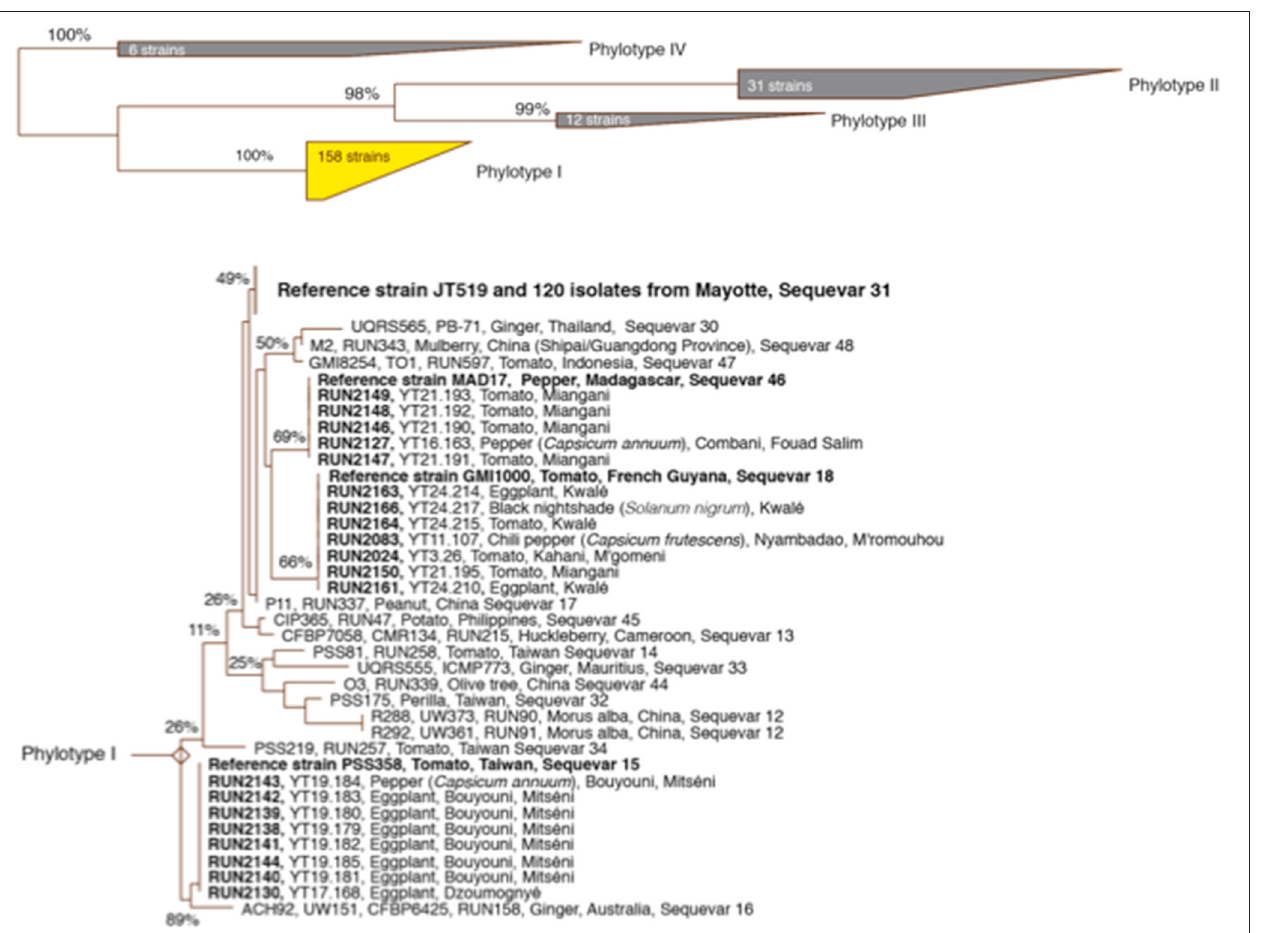
FIGURE 2 | Phylogenetic neighbor-joining tree based on partial endoglucanase ( egl ) gene sequences from strains from Mayotte and reference RSSC strains. The number localized at each node is the bootstrap value ( n = 5,000), with significance < 100% indicated at each node. The scale bar represents 1/100 nucleotide